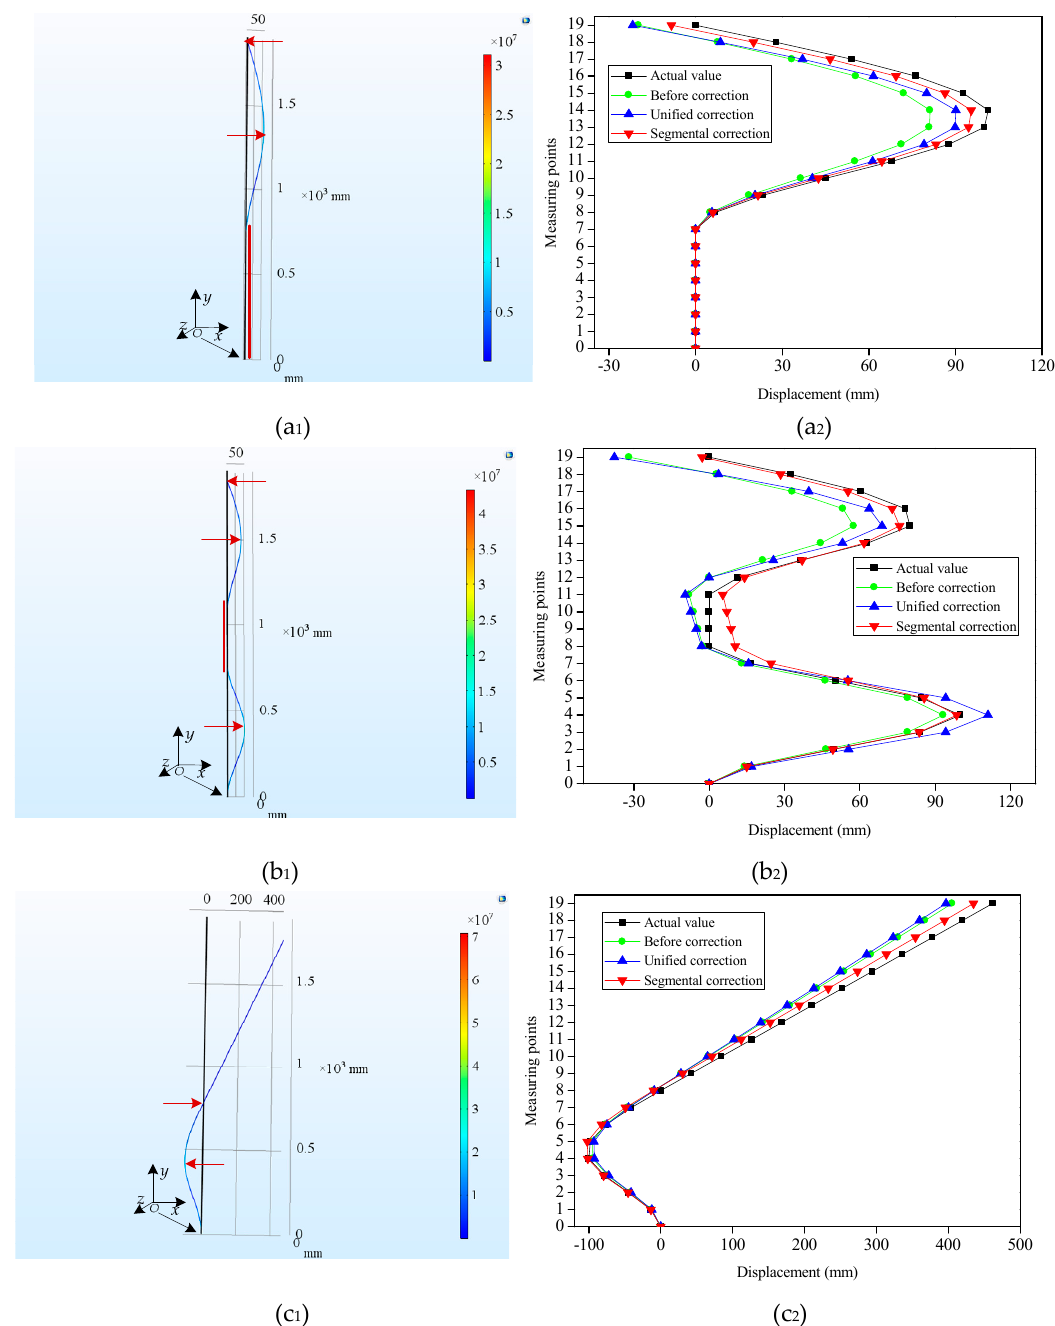
Figure 5. Demonstration of the simulation results of the slender plate model under different loading modes. ( a 1 ), ( b 1 ) and ( c 1 ) represented the simulation diagrams for Type 1, Type 2 and Type 3, respectively; ( a 2 ), ( b 2 ) and ( c 2 ) represented the displacements contrast of the measuring points for Type 1, Type 2 and Type 3, respectively.